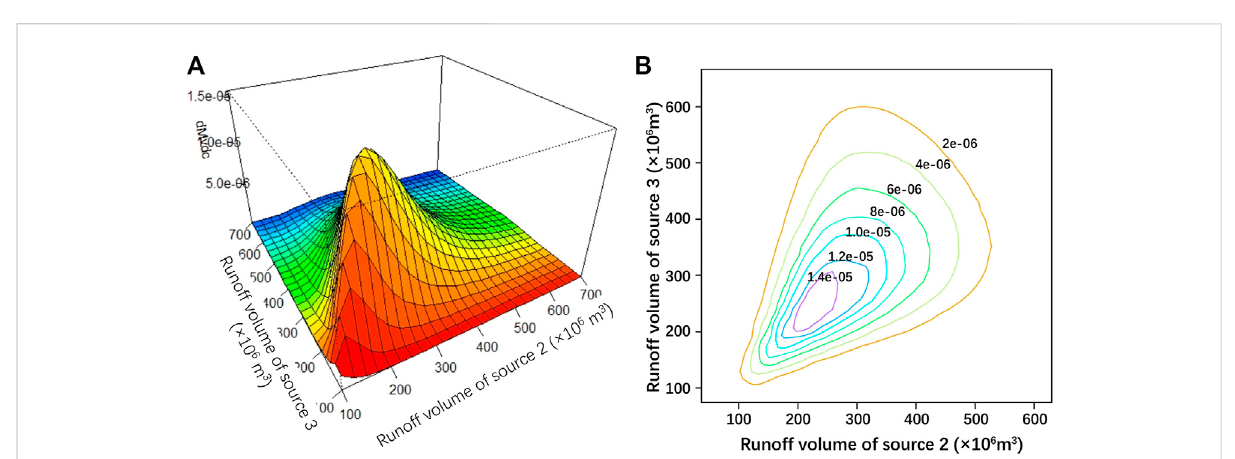
FIGURE 6 (A) Three-dimensional and (B) contour fi gures of joint probability density distributions of source 2 and source